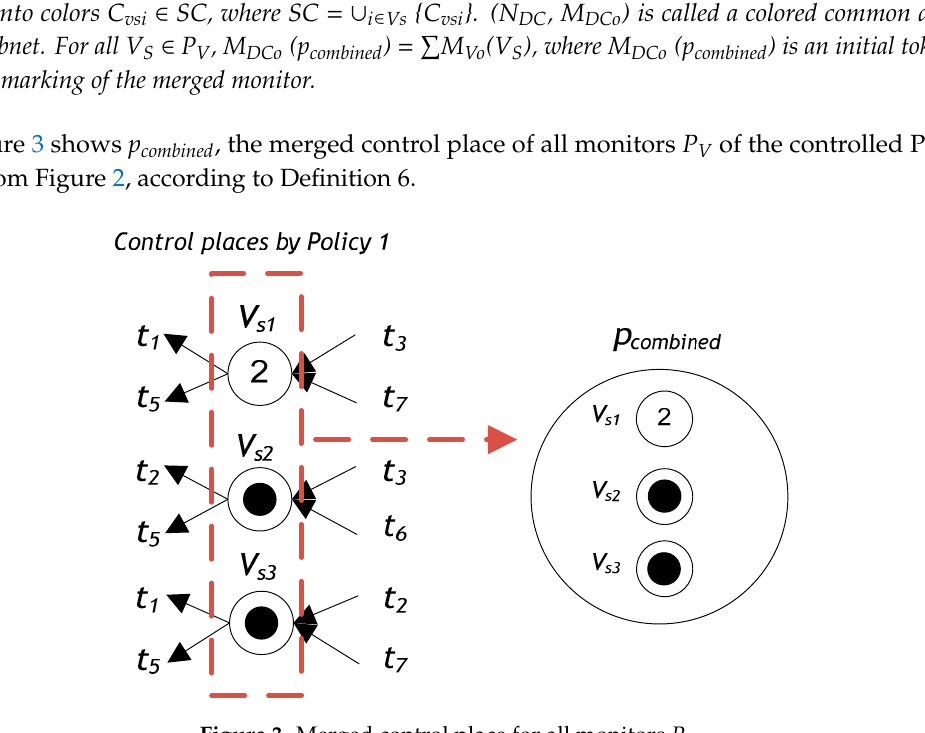
Figure 4. Output arcs of p combined for all monitors P V . The input arcs of p combined are connected with the output of 𝑆 , denoted as T DCi . Transitions · V si for all monitors P V augmented from Algorithm 1 are defined as · V s 1 = { t 3 , t 7 }, · V s 2 = { t 3 , t 6 }, and · V s 3 = { t 2 , t 7 }. Thus, T DCi can be represented by T DCi = ∪ i ∈ V s {· V si }, so T DCi = { t 2 , 2 t 3 , t 6 , 2 t 7 }, as shown in Figure 5.